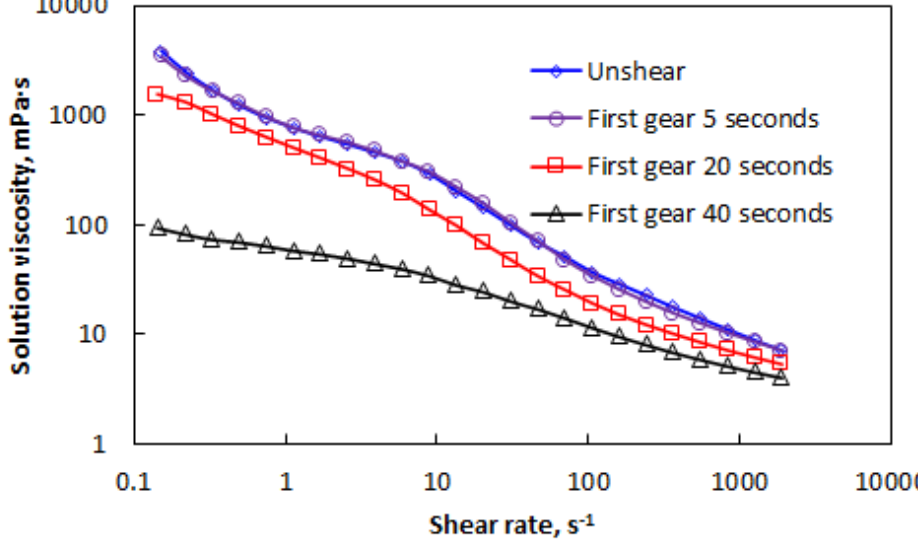
Figure 4. Effect of shear on the rheological curve of AP-P4 at a concentration of 1000 mg/L. As shown in Figure 4, the 1000 mg/L AP-P4 rheological curve decreased gradually with increasing shear rate, but the four rheological curves were significantly different. The association of AP-P4 occurred before the critical association concentration, which enhances the chain stretching, orientation, and entanglement/de-entanglement forces. However, mechanical destruction of the molecular chain by shearing destroys the intermolecular bonding force of the polymer. A stronger degree of mechanical shear damage is associated with a greater impact on intramolecular binding. This result explains the minimal difference between the curve characteristics of samples sheared for 5 s and 20 s, whereas the curve of 40 s of shearing is obviously different. For AP-P4 with a solution concentration of 2000 mg/L, the rheological curves under different shear strengths are shown in Figure 5.